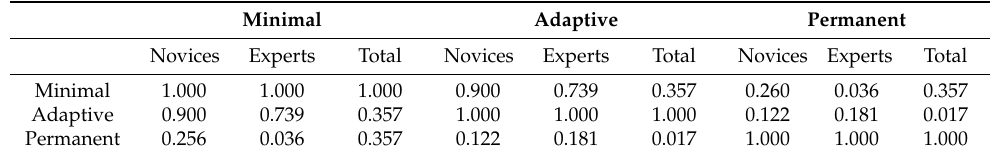
Table 5. Pairwise comparisons using the Nemenyi post hoc test for the time participants took to visualize the target location.